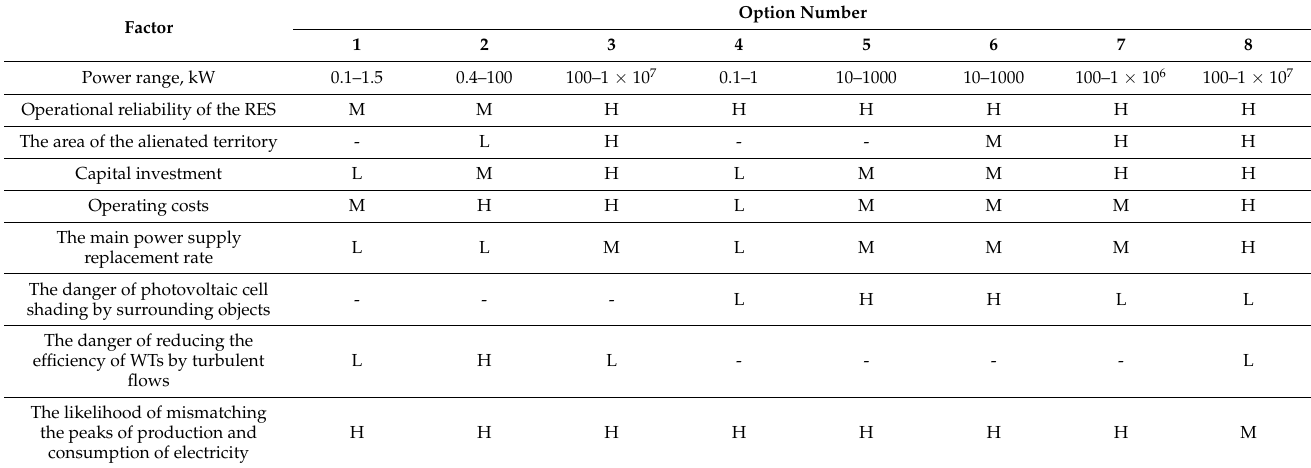
Table 1. Summary table of RE technologies in railway